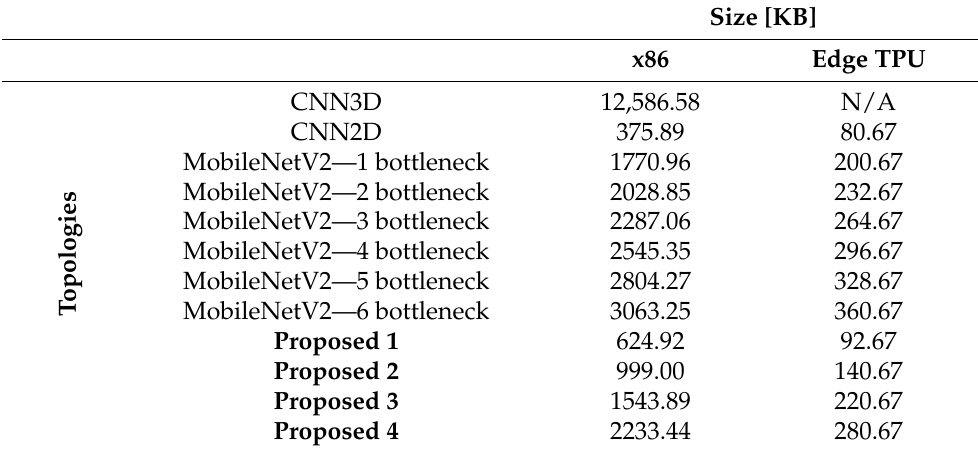
Table 3. Comparative characteristics of model sizes for the non-optimized and the optimized versions.